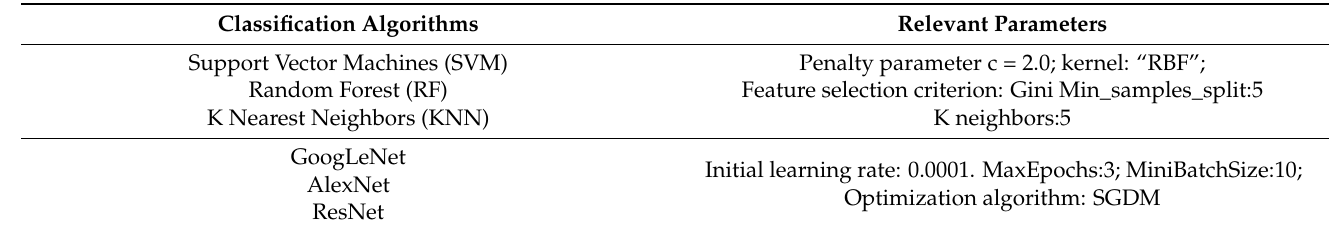
Table 3. Initial parameters used for machine learning and deep transfer learning.